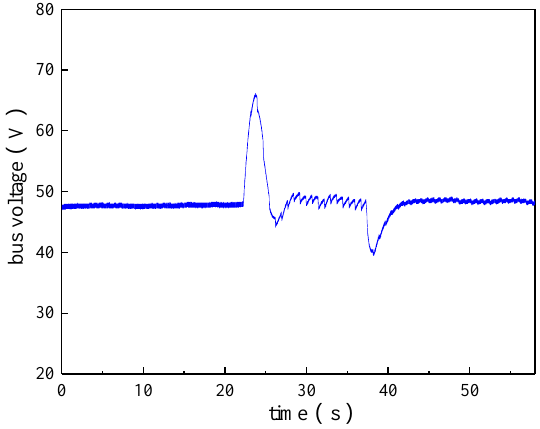
Figure 19. Bus voltage waveform with variable load during generating test. Energies 2017 , 10 , 1609